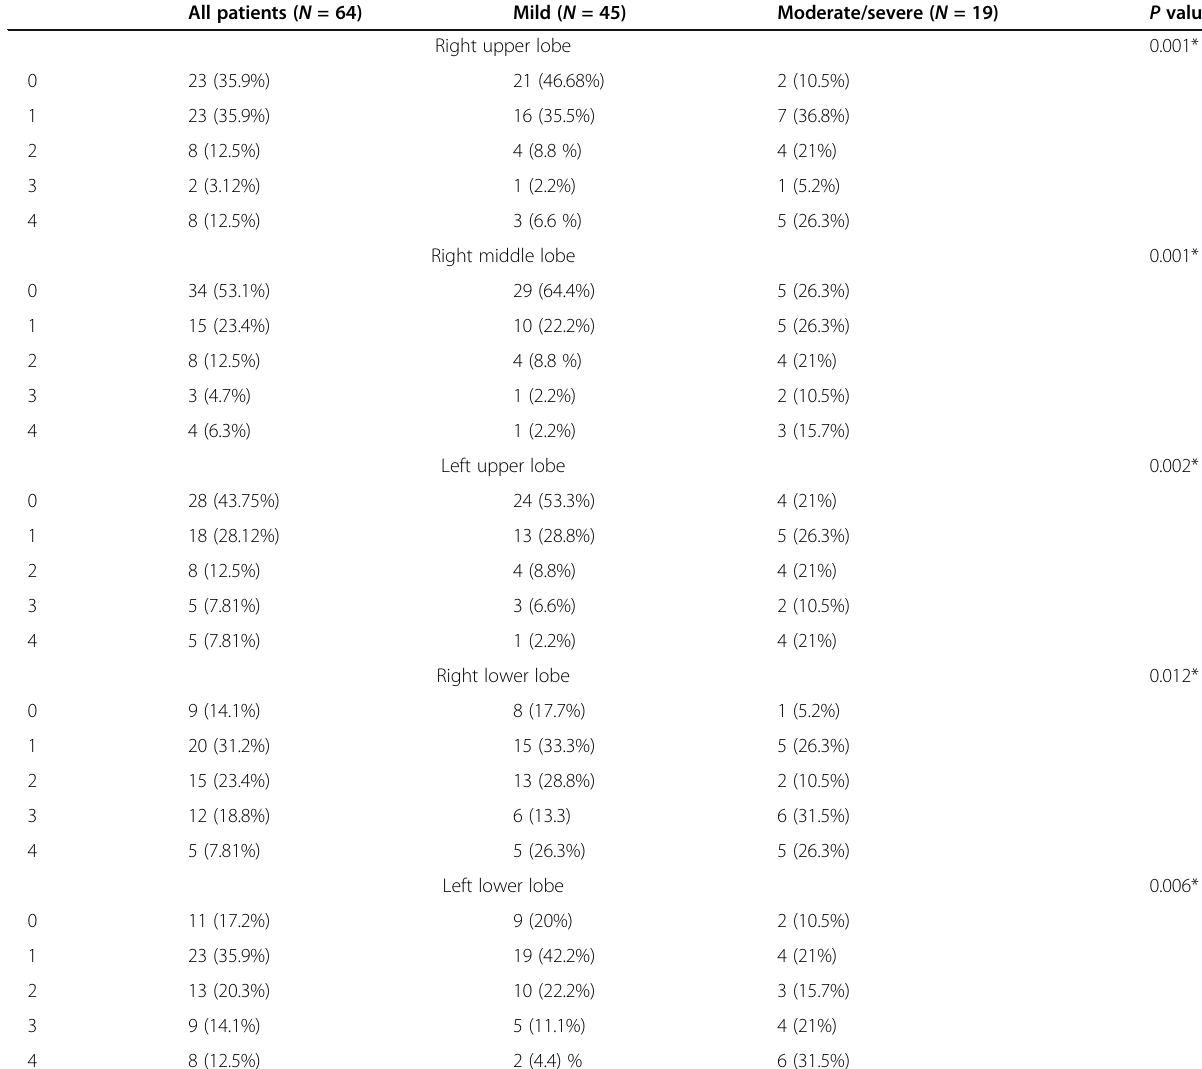
Table 3 The percent of lung lobe involvement (* p < 0.005 defines a significant difference) All patients ( N =